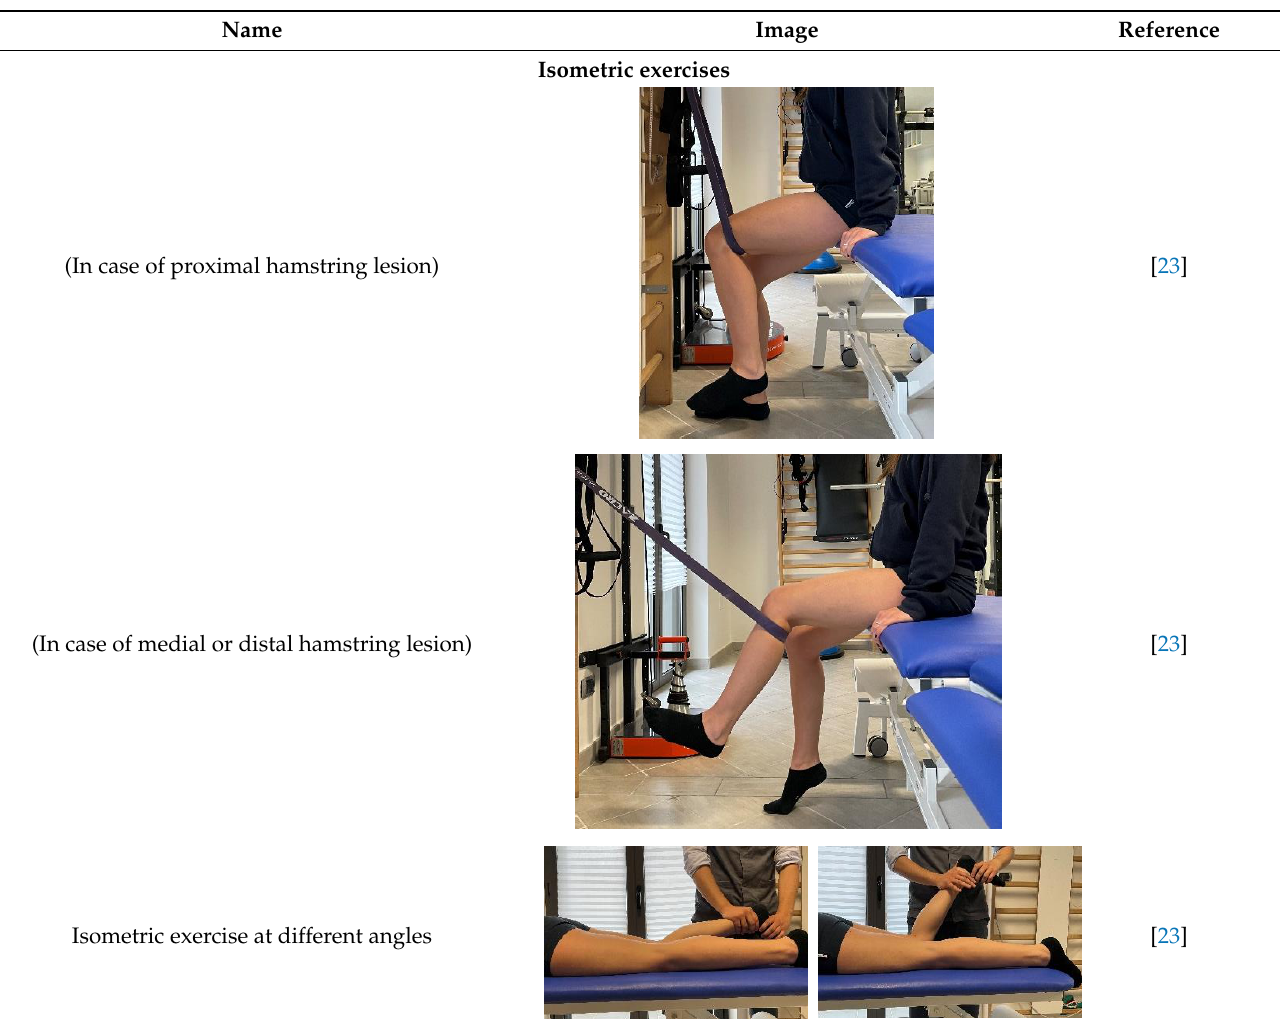
Table 2. Hamstring rehabilitation exercises.